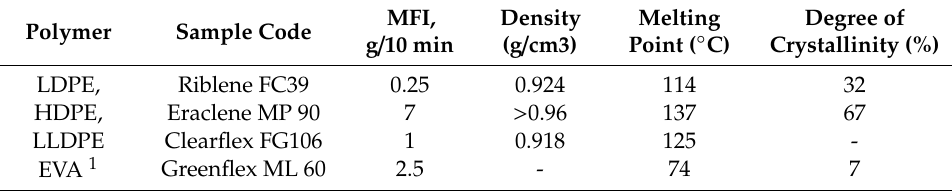
Table 3. Polymers used in this